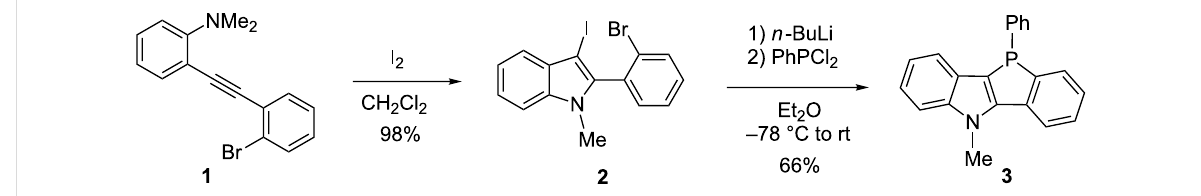
Scheme 1: Synthesis of benzophospholo[3,2- b ]indole 3 .